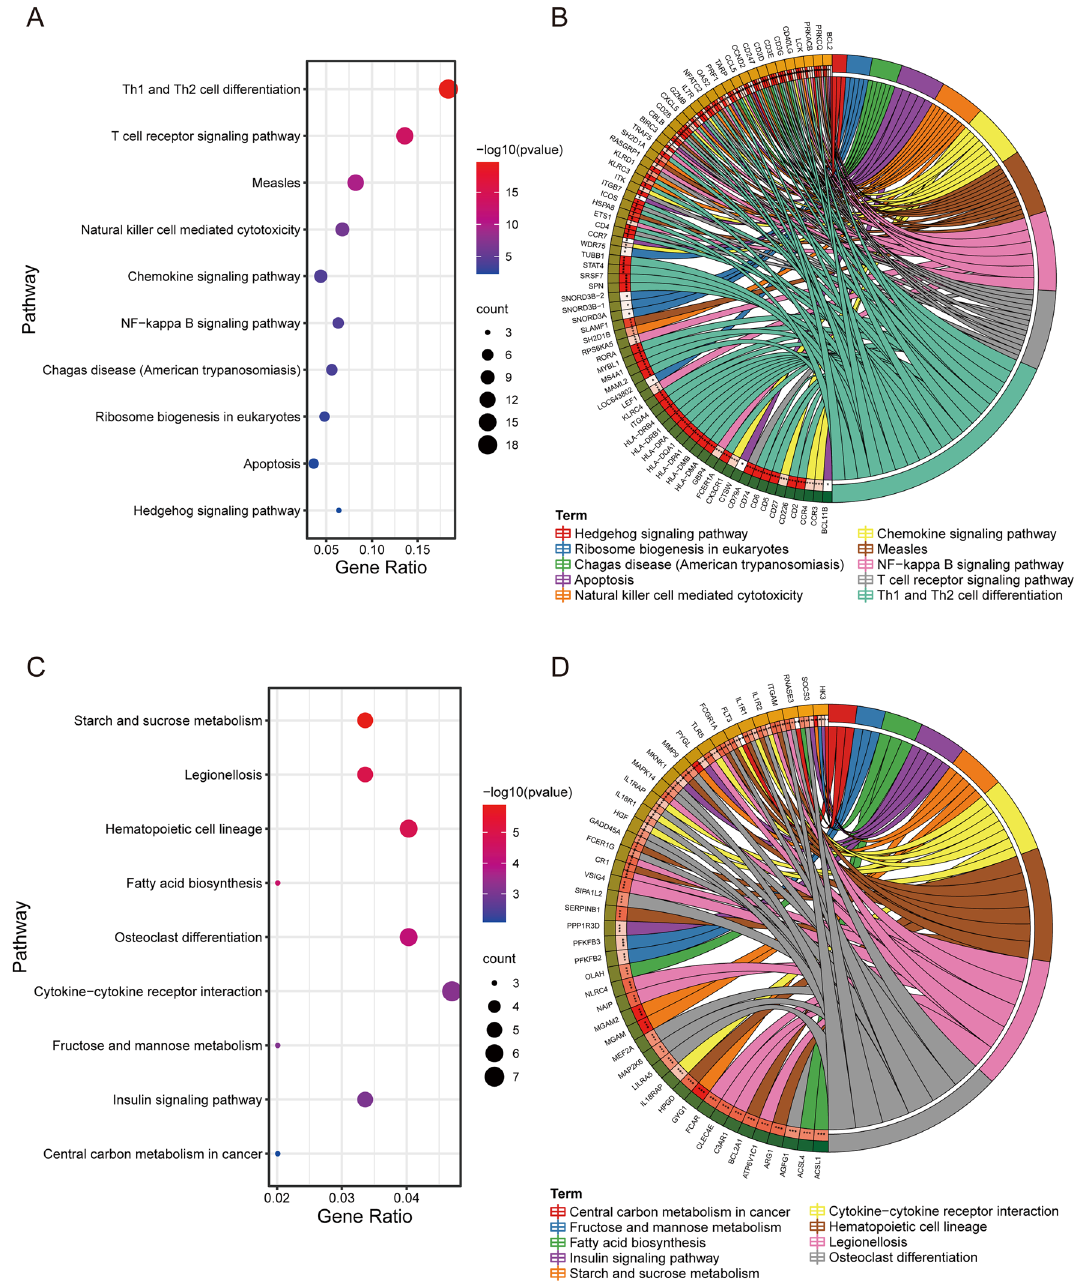
Figure 4. KEGG enrichment analysis of GSE142255 DEGs. The top 10 enriched pathways of downregulated ( A ) and upregulated ( C ) DEGs were visualized in a bubble map. The relationship between downregulated ( B ) or upregulated ( D ) DEGs and pathways were visualized in a string